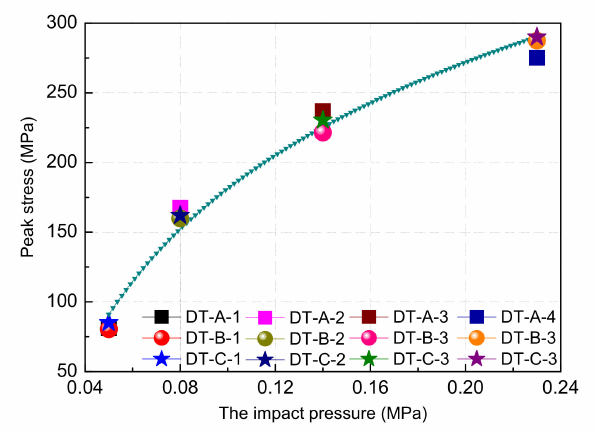
Figure 4. The relationship between peak stress and impact